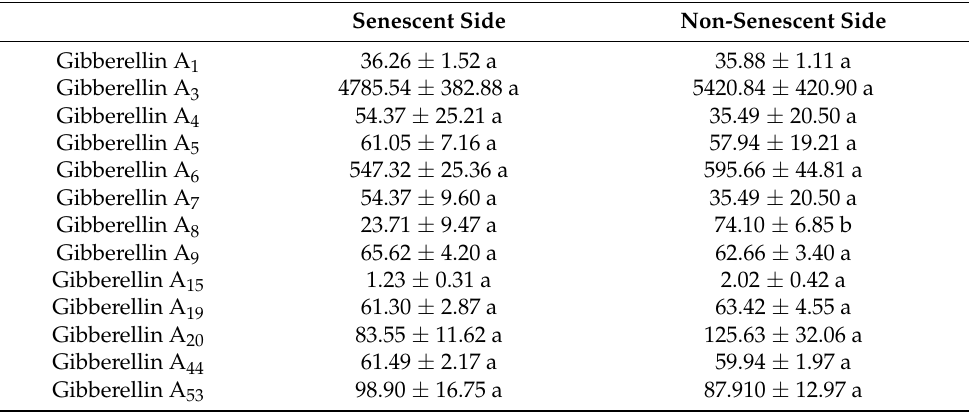
Table 1. Endogenous levels of gibberellins in the senescent and non-senescent sides of the SAZ, induced by JA-Me in the internode explants of Bryophylum calycinum . Values are the mean with standard error (n = 6). Different letters (a, b) on the column indicated statistically significant at p < 0.05 after ANOVA.